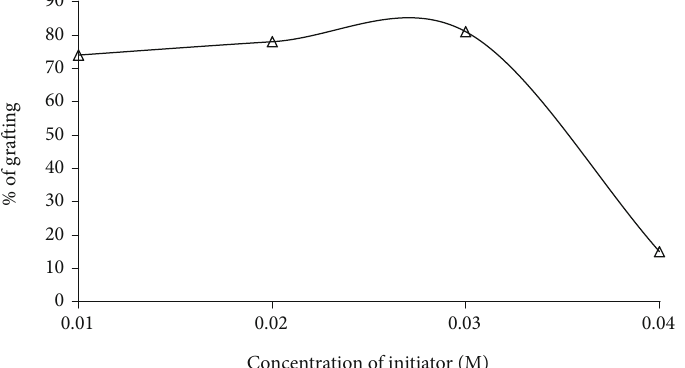
Figure 3: E ff ect of the amount of initiator H ( Δ ): % of